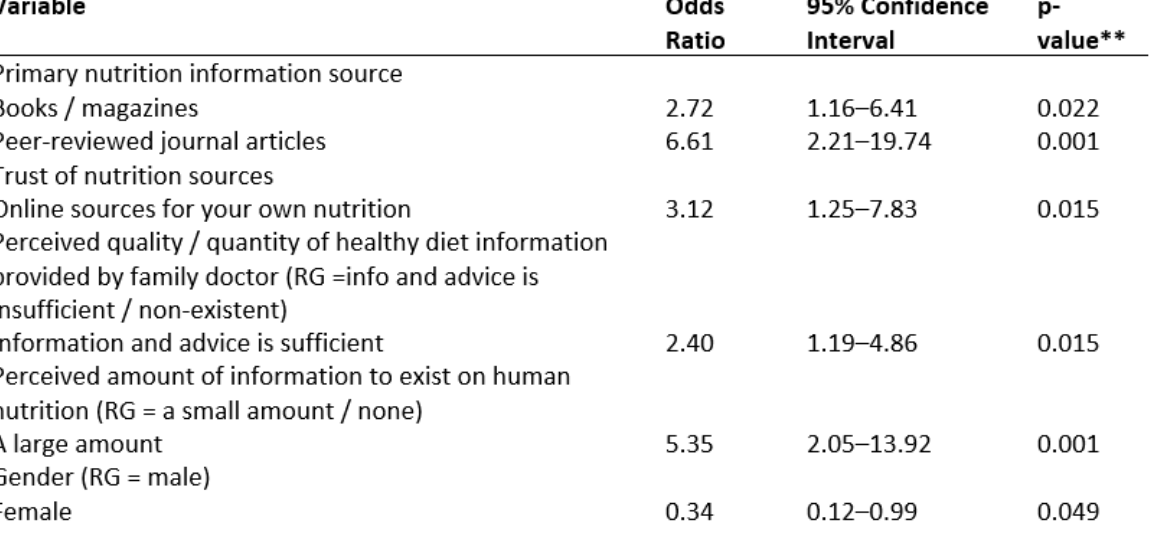
Table 5. Reduced* multivariable logistic regression results of variables influencing first year Canadian and US veterinary students’ self -reported confidence in personal nutrition information-seeking abilities showing significant variables, odds ratios, 95% confidence intervals, and significance values